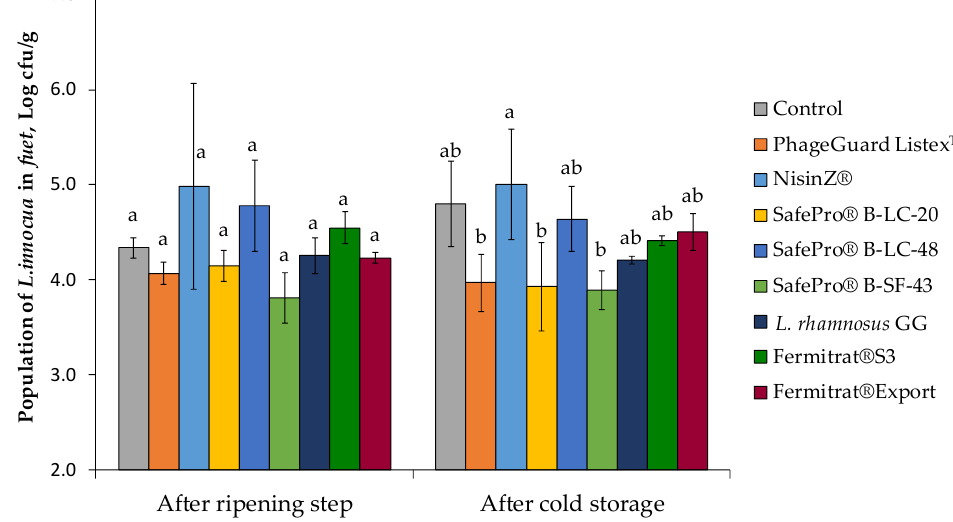
Figure 5. Effect of the biopreservative treatments on L. innocua population in fuet after ripening (7 days at 15 ° C) and cold storage (7 days at 4 °C). Values are means ± standard deviations of three biological replicates. Bars marked with different letters (a and b) represent statistically significant differences among treatments ( p < 0.05) at each sampling time.